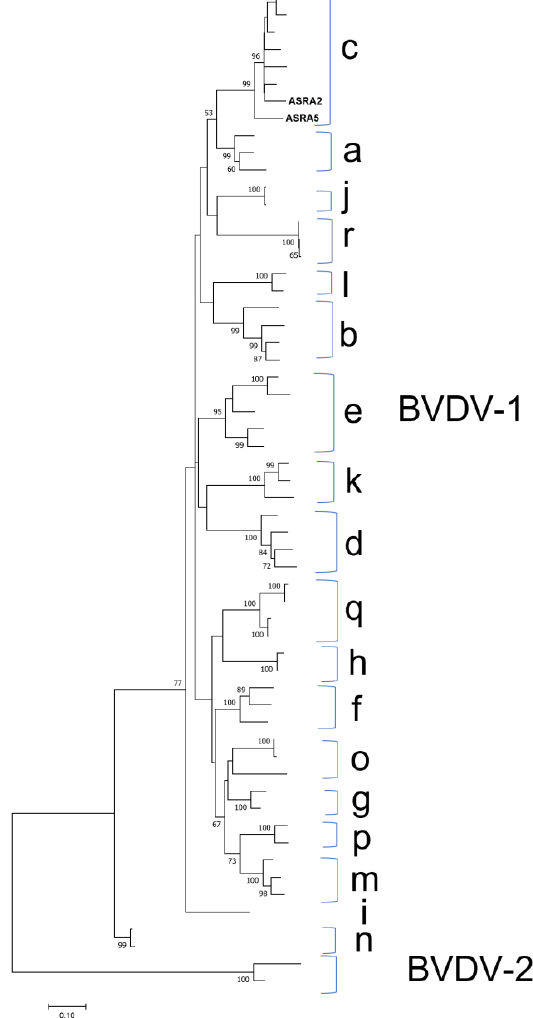
Figure 4. Phylogenetic tree of Bovine Viral Diarrhoea Virus 1 (BVDV-1) based on the N pro gene